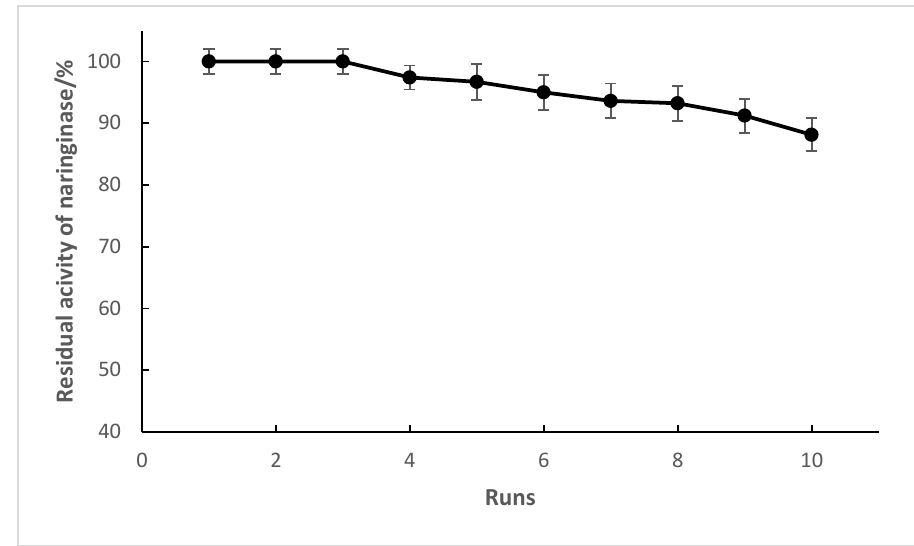
Figure 8. Degree of naringin hydrolysis contained in fresh grapefruit juice after 10 reutilization runs.